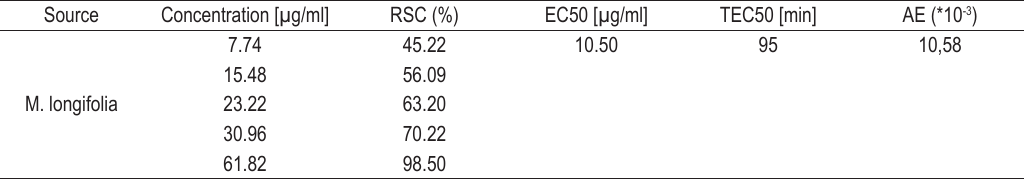
FIGURE 7. Antimicrobial activity against Salmonella enterica subsp.enterica TABLE 3. Percentage of neutralization of DPPH. of essential oil of M. longifolia and trolox as positive control in DPPH